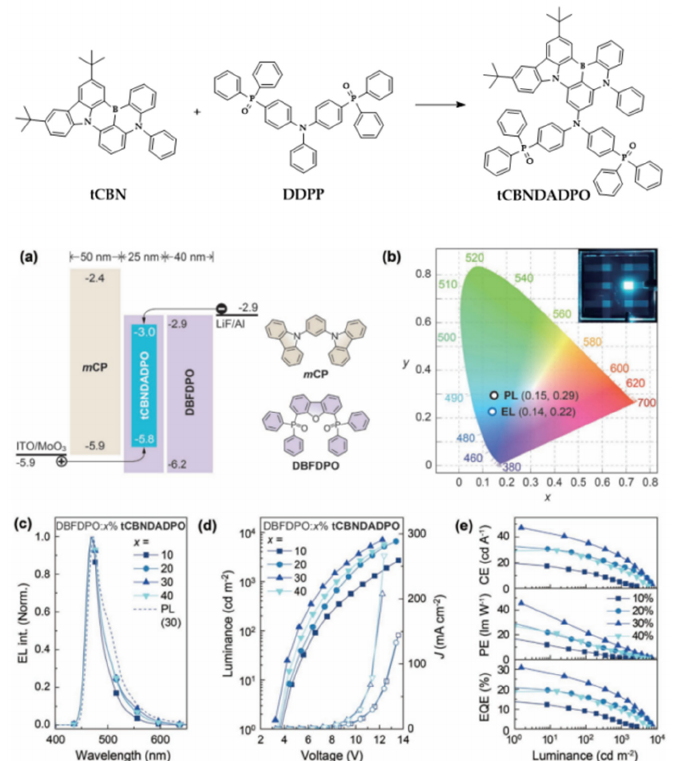
Figure 2. Host – guest integration strategy for constructing tCBNDADPO to combine high color purity and efficiency. ( a ) Energy level diagram of devices and chemical structures of host and carrier transporting materials; ( b ) CIE coordinates of PL and EL emissions from DBFDPO:30% tCBNDADPO and device photo at 5 V; ( c ) concentration dependence of EL spectra and comparison to PL spectrum of 30% doped film; ( d ) variation of current density (J, hollow symbols)–voltage–luminance (solid symbols) characteristics at different x%; ( e ) dependence of efficiency versus luminance curves on x%. Reproduced with permission from Jinkun Bian, Su Chen, Lili Qiu et al., “Ambipolar Self-Host Functionalization Accelerates Blue Multi-Resonance Thermally Activated Delayed Fluorescence with Internal Quantum Efficiency of 100%”; published by John Wiley and Sons , 2022 [44].